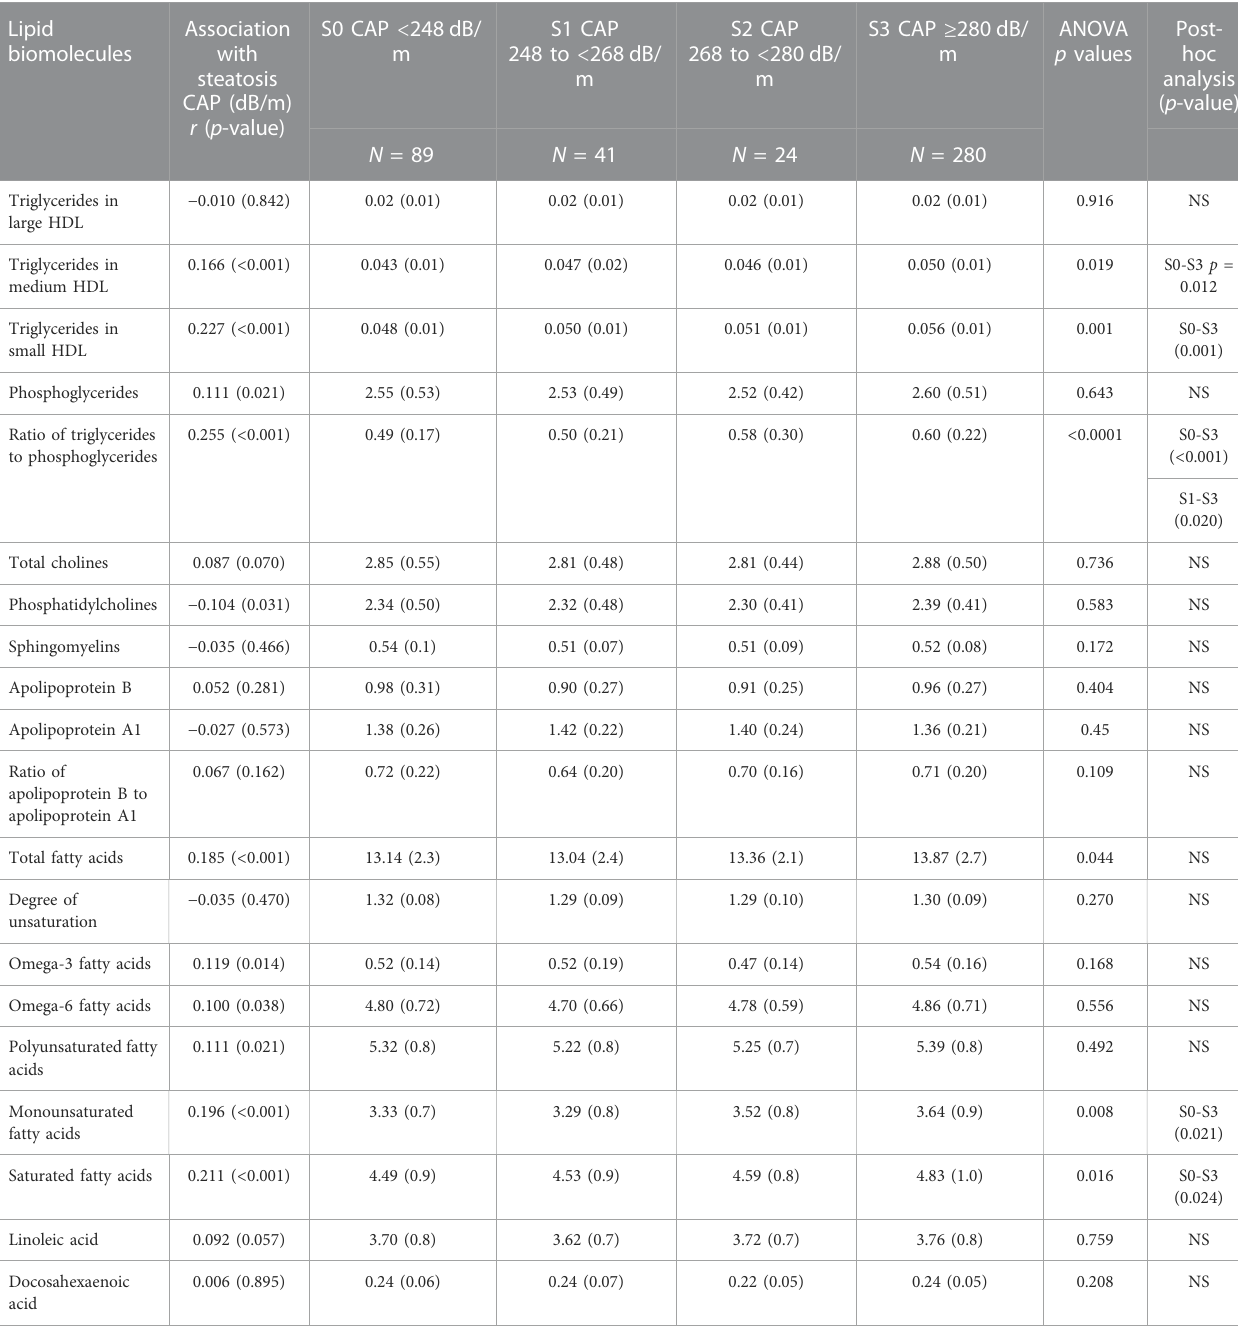
TABLE 1 ( Continued ) Association of lipid biomolecules to steatosis, and lipid biomolecules according to steatosis grades in patients with